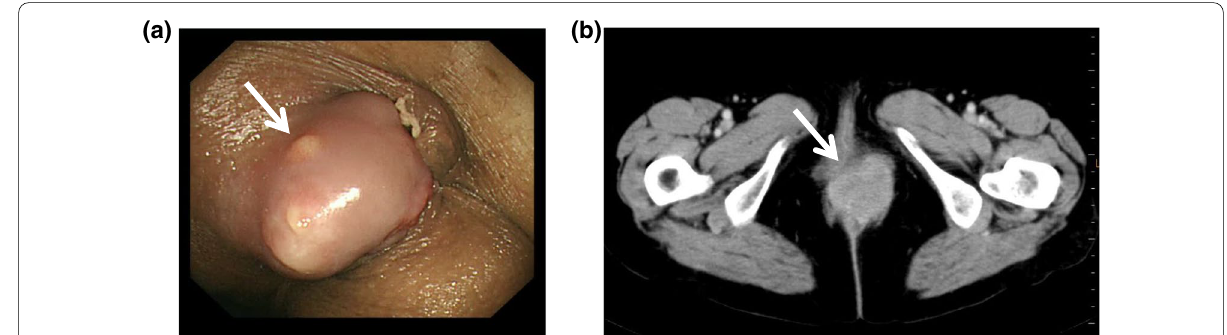
Fig. 1 a Endoscopic evaluation revealed an anorectal mass (white arrow). b An enhanced pelvic CT scan showing the mass at the anal canal (white arrow). CT computed